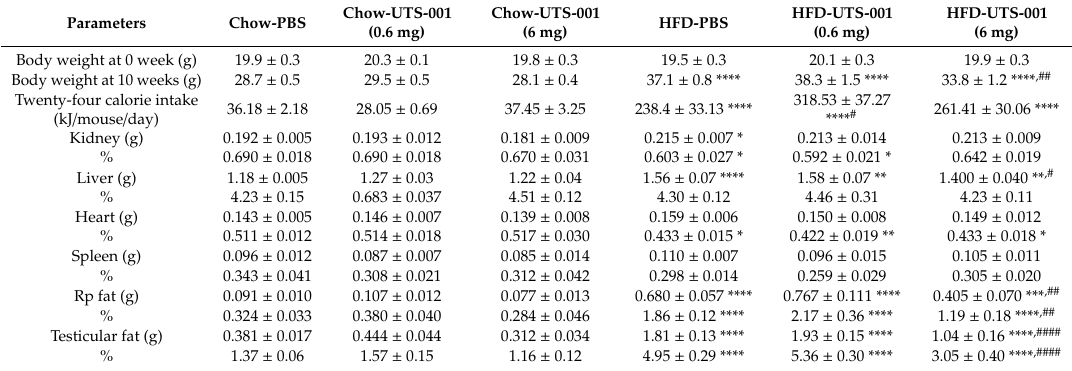
Table 1. E ff ects on anthropometric parameters of mice with HFD and UTS-001 treatment. Parameters